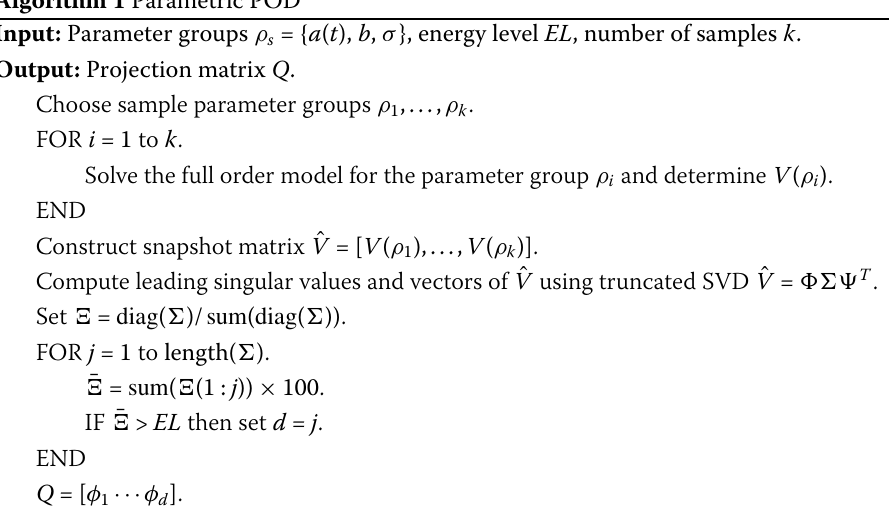
Algorithm 1 Parametric